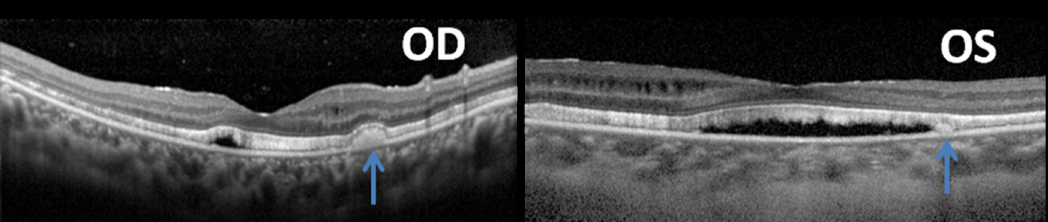
Fig 3. OCT images of a 23-year-old female patiento. OCT imagesof right and left eyes showingthinningof the retinal nerve fiber layer, diffusedserous neuroretinal detachment, parafoveal intraretinal fluid collections, hyperreflective subretinal accumulations (blue arrows), elongated and thickened photoreceptor outer segmentlayer.